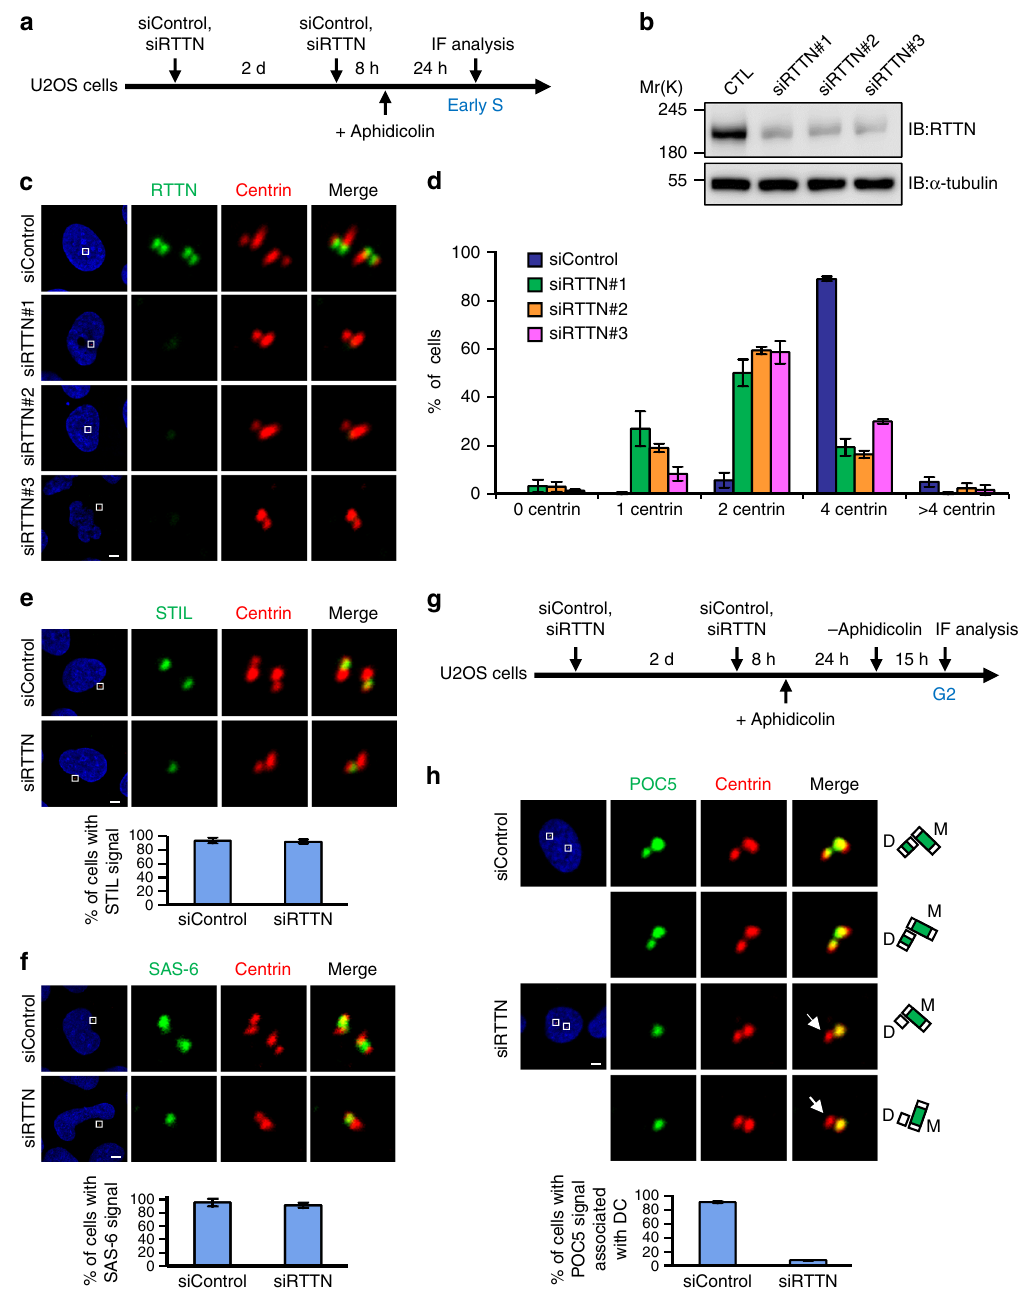
Fig. 1 RTTN is required for normal centriole duplication. a – c U2OS cells were treated with siControl or siRTTN (#1, #2, #3) and synchronized at early S phase, as described in a . The cells were analyzed by immunoblotting b or immuno fl uorescence confocal microscopy c using the indicated antibodies. d Histogram illustrating the percentages of cells exhibiting centrin signals. Error bars represent the mean ± s.d. from three independent experiments ( n = 100/experiment). e , f U2OS cells were treated with siControl or siRTTN as described in a , and then stained with the indicated antibodies. Histogram illustrating the percentages of cells exhibiting STIL e or SAS-6 f signals. Error bars represent the mean ± s.d. from three independent experiments ( n = 100/experiment). g , h U2OS cells were treated with siControl or siRTTN, enriched at G2 phase as described in g , and stained with the indicated antibodies. Histogram illustrating the percentages of cells with a POC5 signal associated with daughter centriole (DC). Error bars represent the mean ± s.d. from three independent experiments ( n = 100/experiment). Scale bar , 5 μ